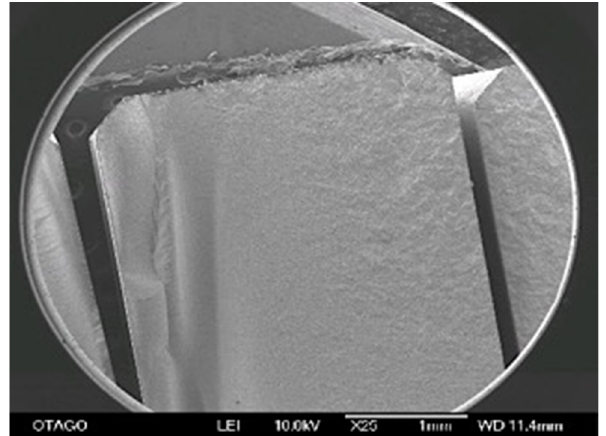
Figure 5. SEM images showing an example of fracture pattern at 25× magnification (group CP). Note the more course fractured surface for highest flexural strength specimens.